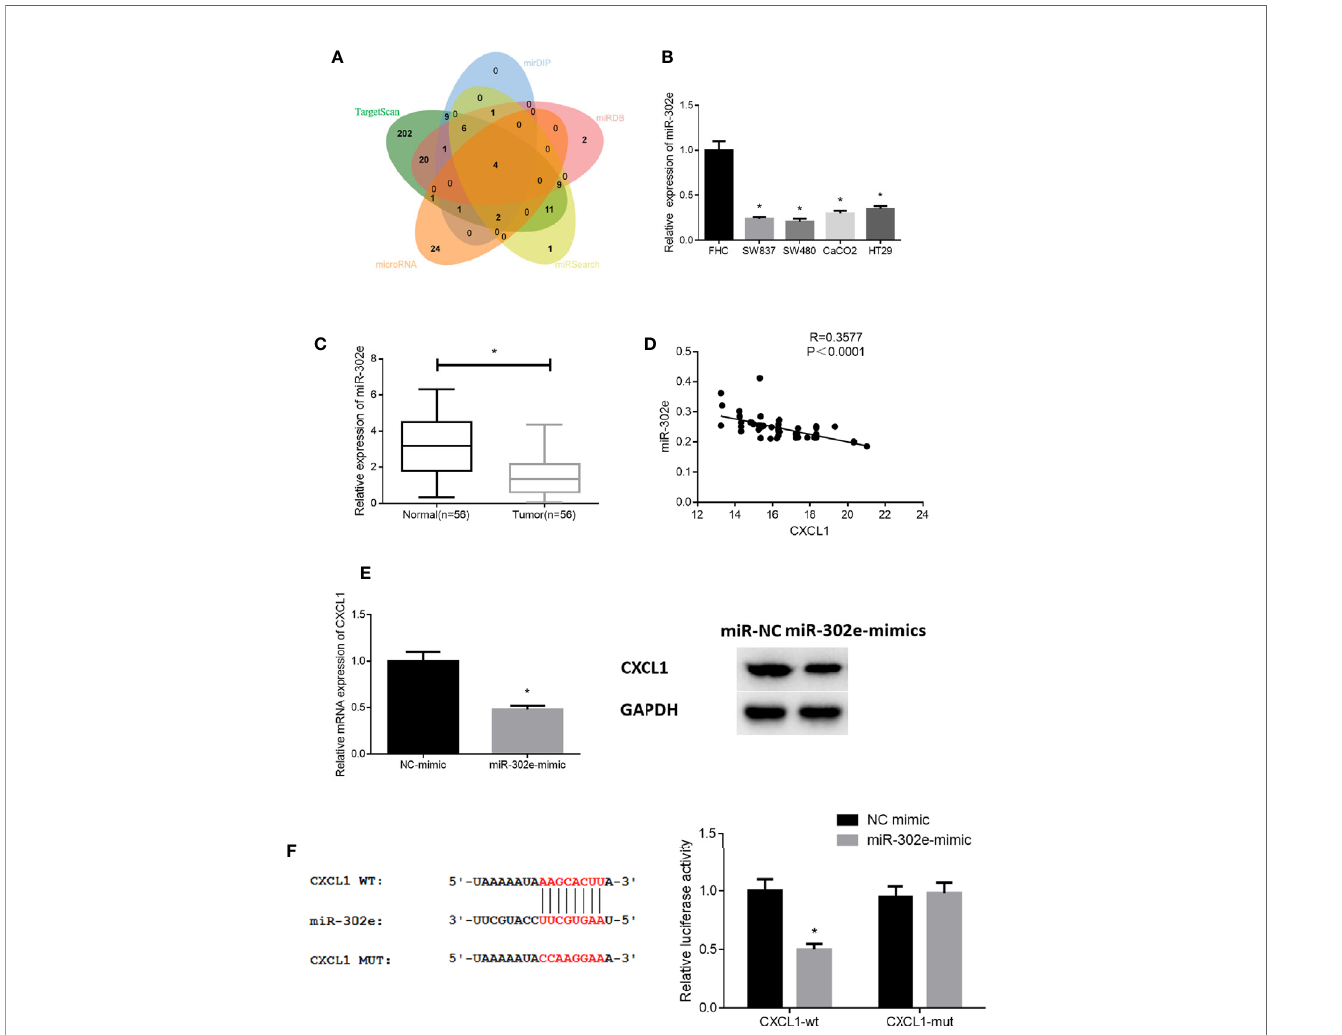
FIGURE 4 | miR-302e targets CXCL1 in CRC cells. (A) Venn diagram shows the overlapping miRNAs from genes predicted by TargetScan, mirDIP, miRDB, miRSearch, and microRNA databases, (B, C) qRT-PCR results showed the expression level of miR-302e in (B) CRC cell lines SW837, SW480, CaCO2, HT29, and normal colorectal mucosa cell line FHC, as well as in (C) clinical tumor tissue samples and adjacent normal tissue samples (n = 56), (D) Pearson correlation analysis showed that there was a negative correlation between CXCL1 and miR-302e levels, (E) qRT-PCR and Western blot were conducted to show the relative mRNA and protein expression of CXCL1 after miR-302e mimic and mimic NC were transfected into SW480 cells, (F) Dual-luciferase reporter assay was performed to validate the direct targeting relationship between miR-302e and CXCL1 (* p <